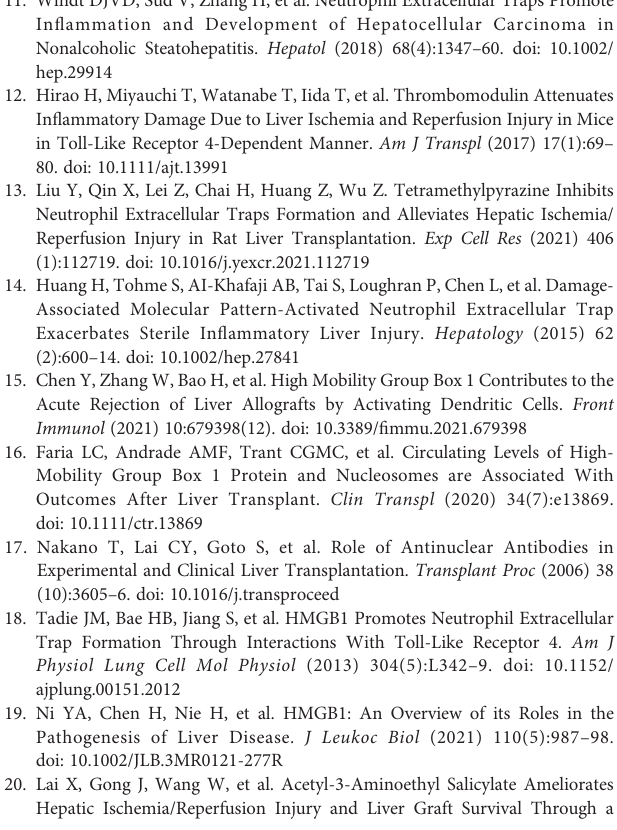
Supplementary Figure 1 | Immuno fl uorescence of neutrophils and kupffer cells. (A) Images of neutrophils isolated from patients (magni fi cation, x200;